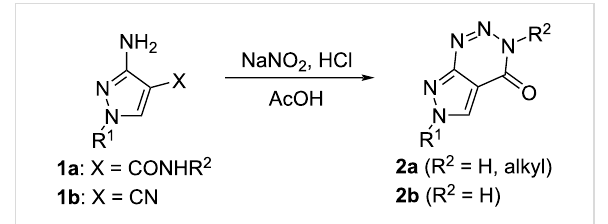
In the past, it was shown that ortho -methylamide-substituted aryltriazenes 7 could be efficiently converted into 3,4-dihy- drobenzo[ d ][1,2,3]triazine derivatives 8 [37] (Scheme